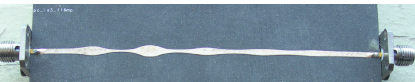
Figure 11: Photograph of a microstrip pulse shaper for UWB radar and communication systems.